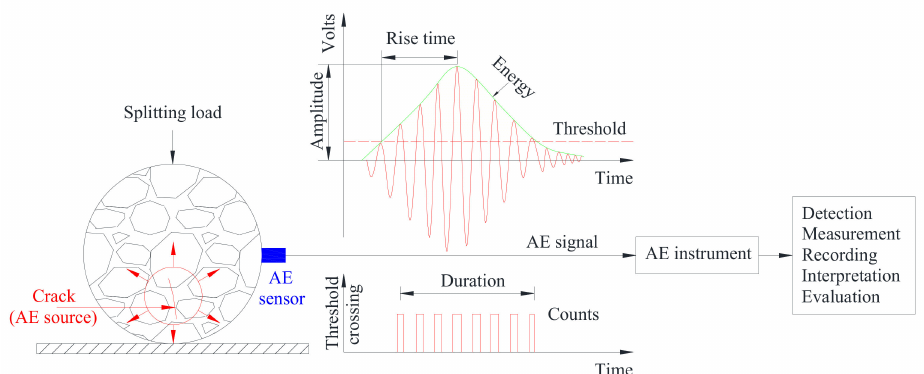
Figure 3. Schematic diagram of AE monitoring under indirect tensile